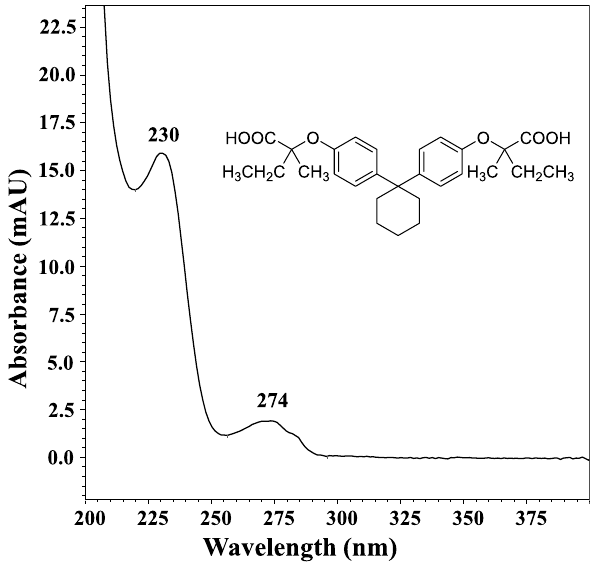
Fig. 1 Chemical structure of CF and its UV absorption spectrum recorded by the PDA